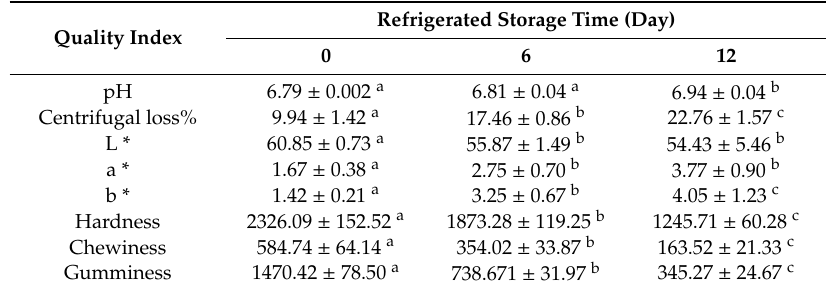
Table 1. Quality deterioration of grouper fillets during refrigerated storage for 0, 6, and 12 days at 4 ◦